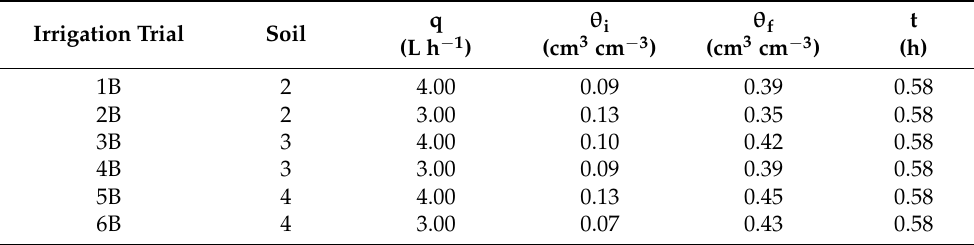
Table 4. Characteristics of the short-duration irrigations of the second experimental block.